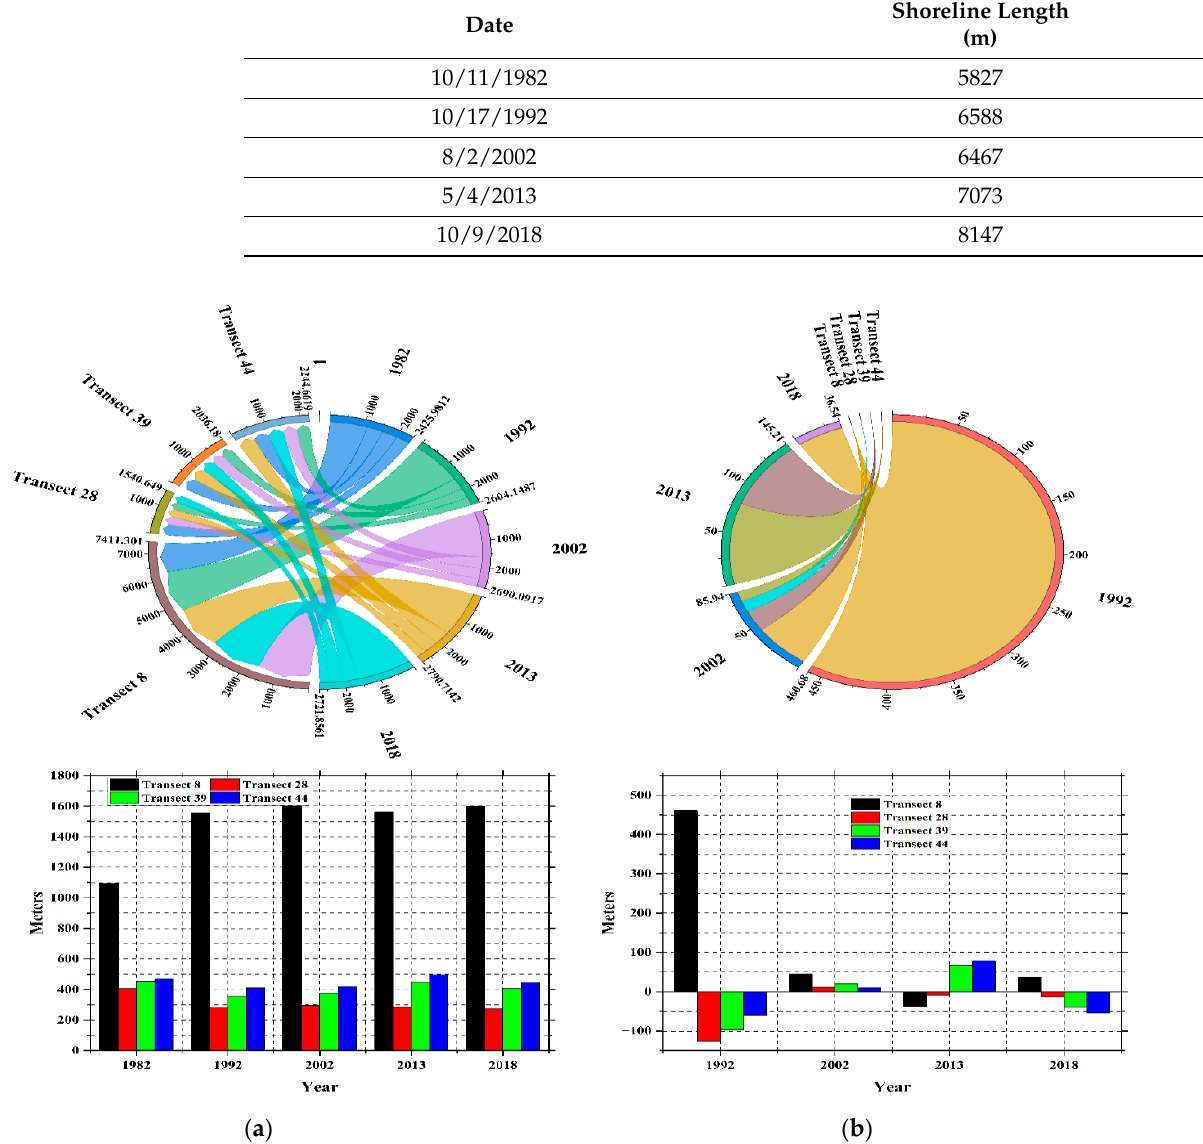
Table 9. Shoreline length data of Segment F.